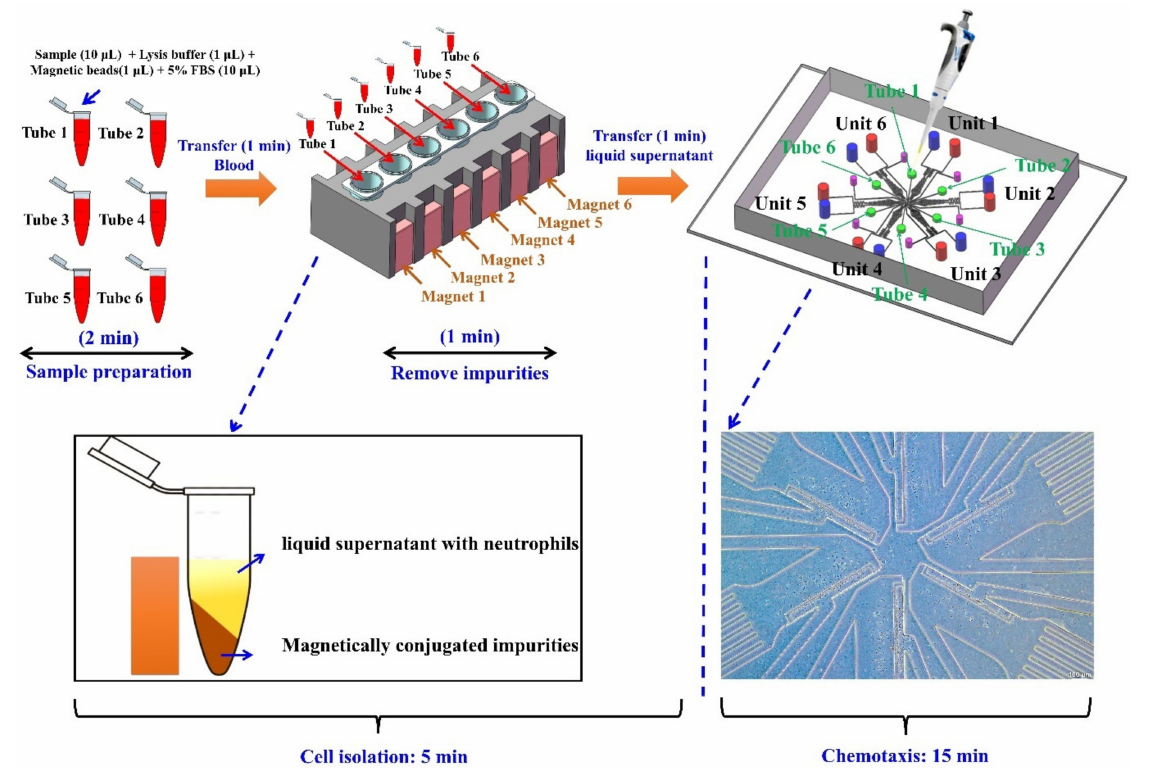
Figure 1. The operation progress of the “sample in and chemotaxis out”